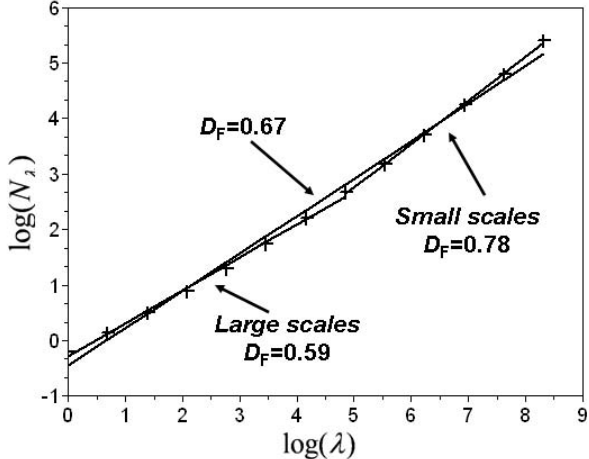
Fig. 2. Computation of the fractal dimension (Eq. 1 in a log–log plot) of R λ for C 1 = 0 . 1, α = 1 . 9, γ 0 = 0 . 1 and p 0 = 0 .